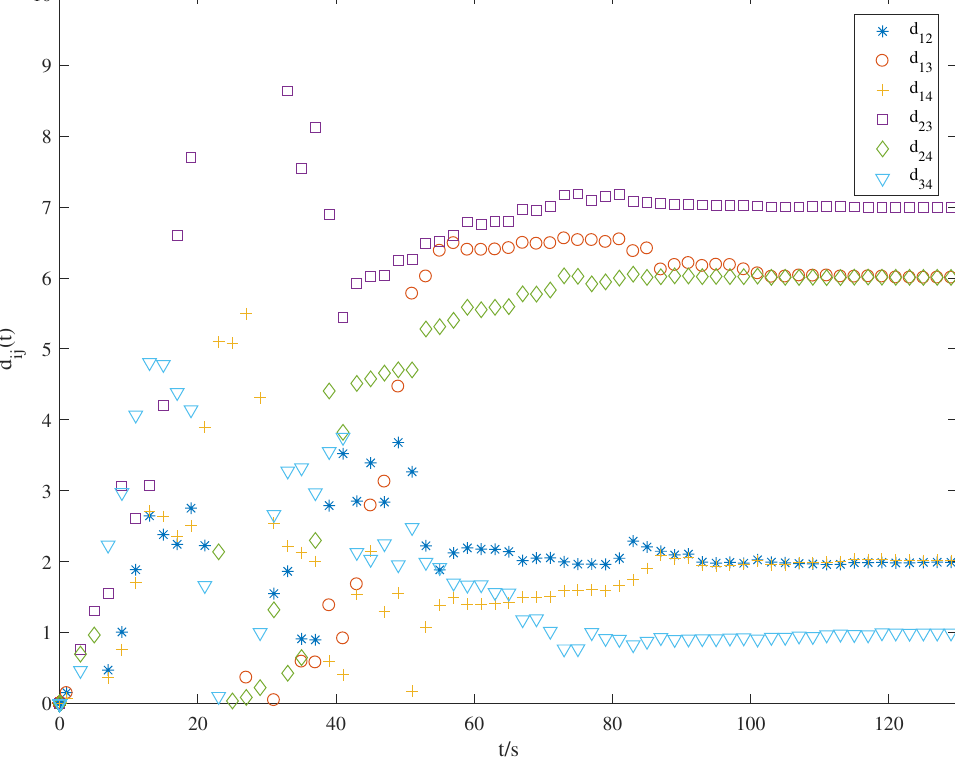
Figure 4. Topology identification for the dynamical network in Example